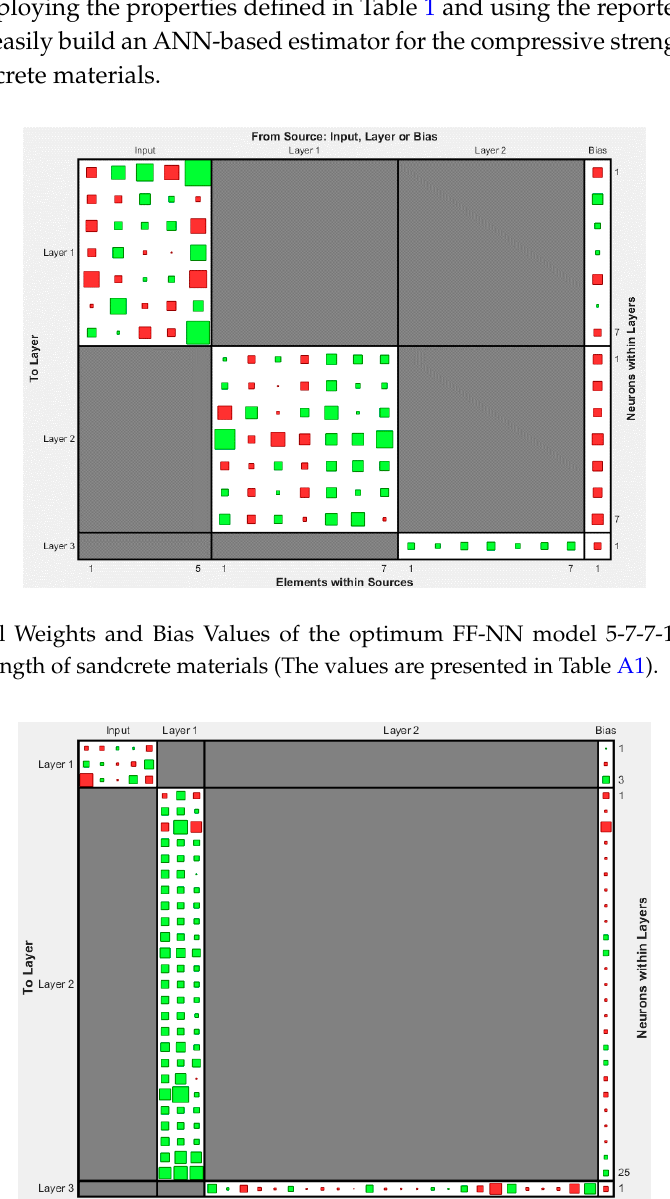
Figure 9. Experimental vs predicted values of modulus of elasticity for the best with two hidden layers BPNN (5-3-25-1).